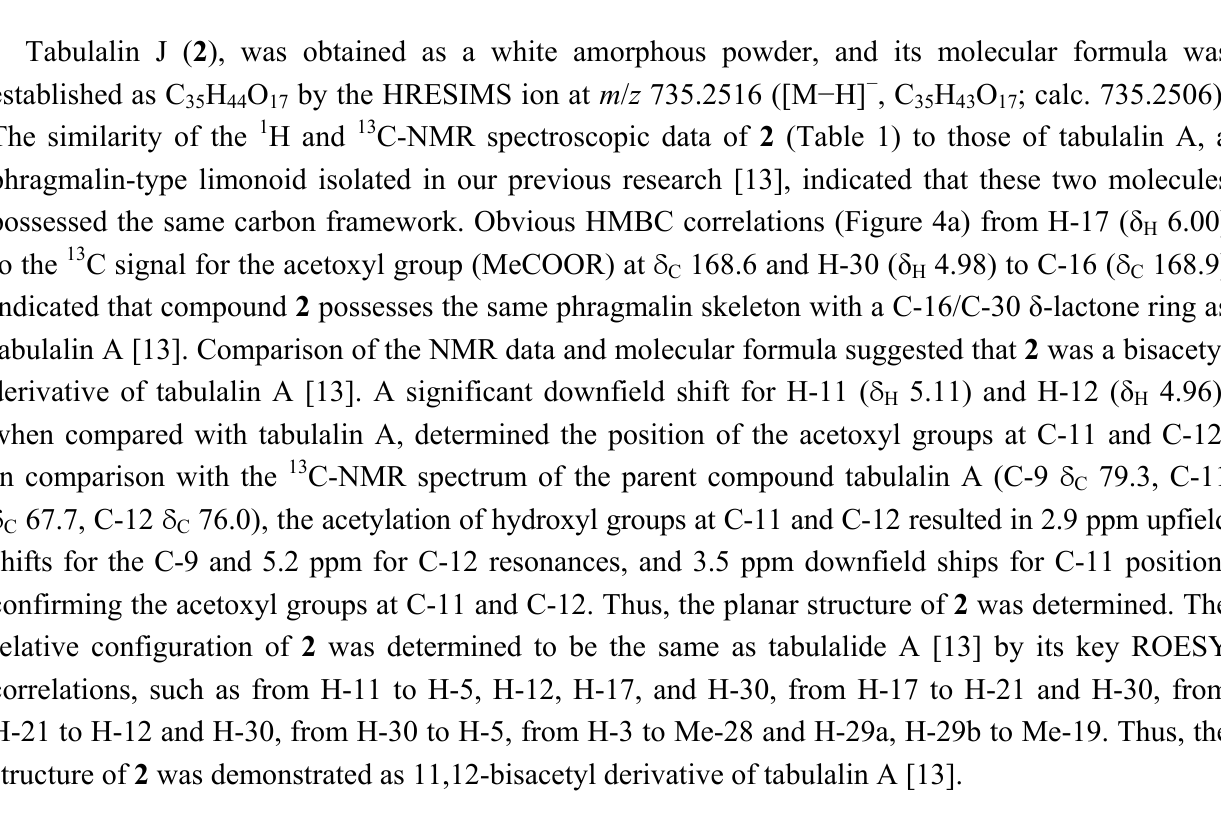
Figure 4. Key HMBC correlations of compound 2